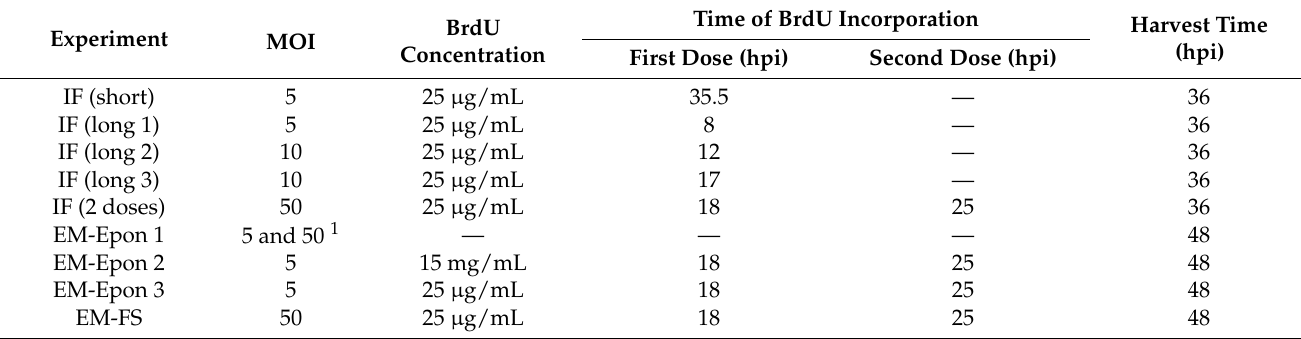
Table 1. Conditions tested for BrdU labeling. IF: immunofluorescence microscopy; EM: electron microscopy: FS: freeze- substitution. Short or long indicate the length of BrdU pulse.